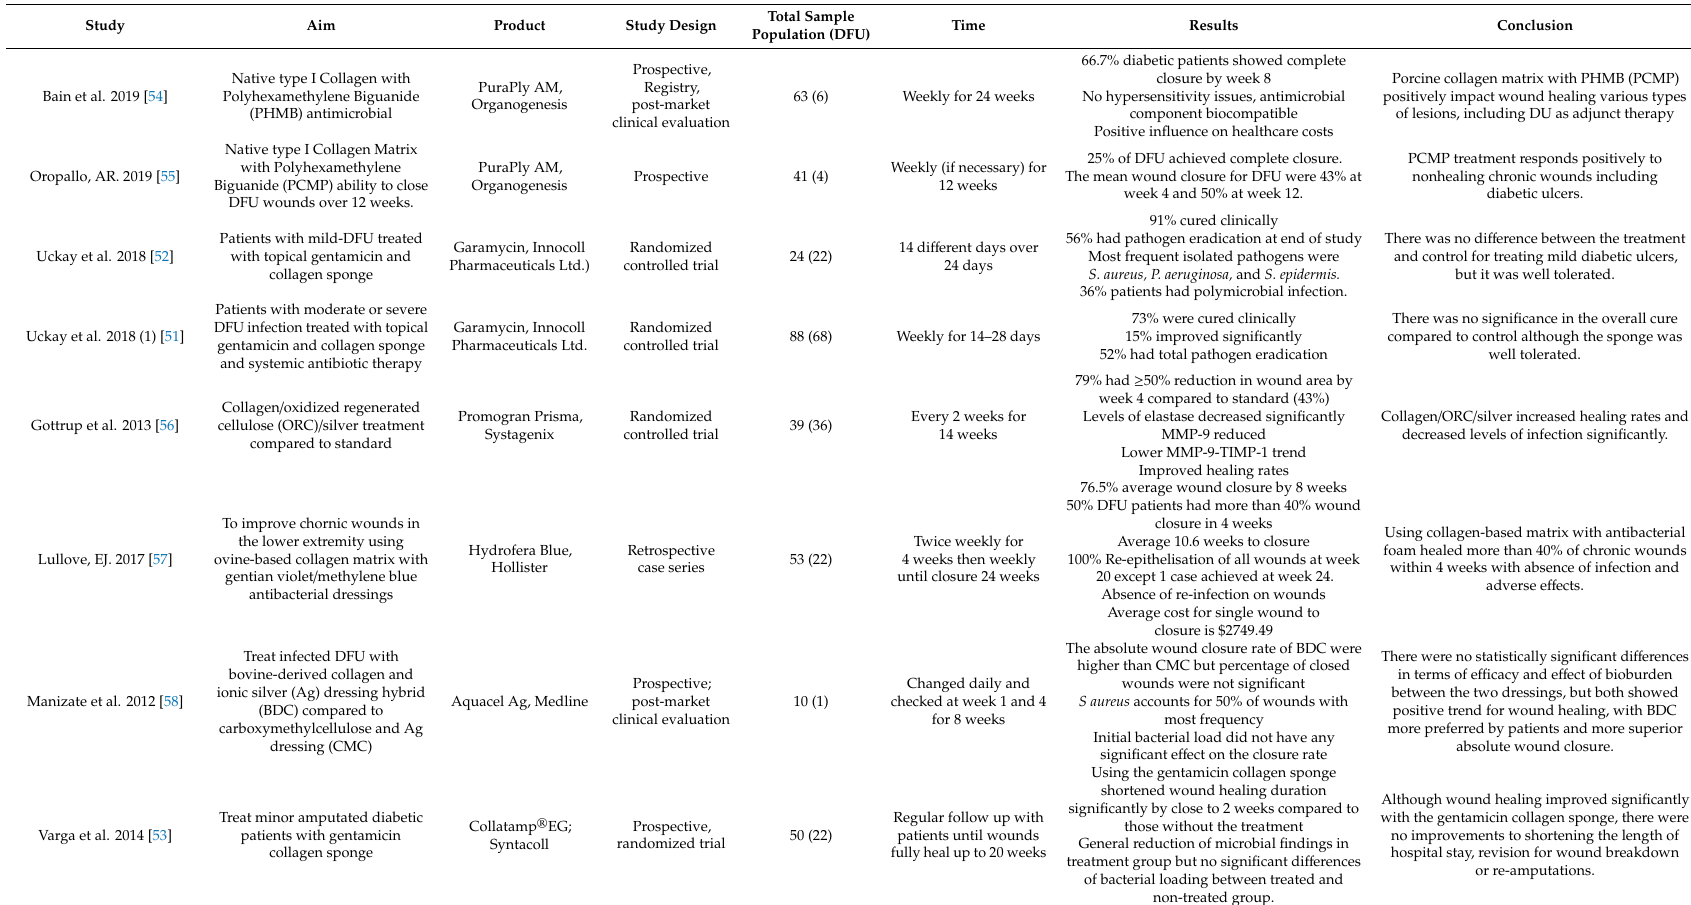
Table 2. A summary of studies of antibacterial sponge-like sca ff olds for chronic wound